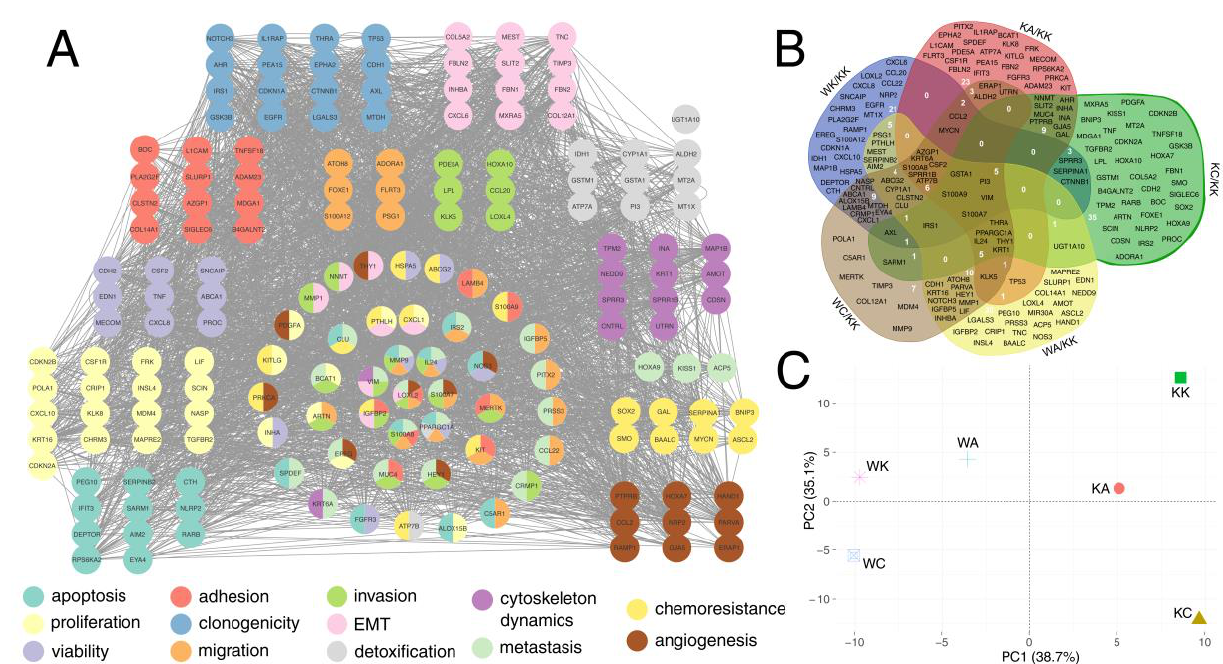
Figure 7. Visualization of definitive network and the PCA of cellular variants using gene expression data. ( A ) Definitive network with emphasis on processes. ( B ) Intersection analysis of definitive network. ( C ) PCA using expression data of genes from definitive network.